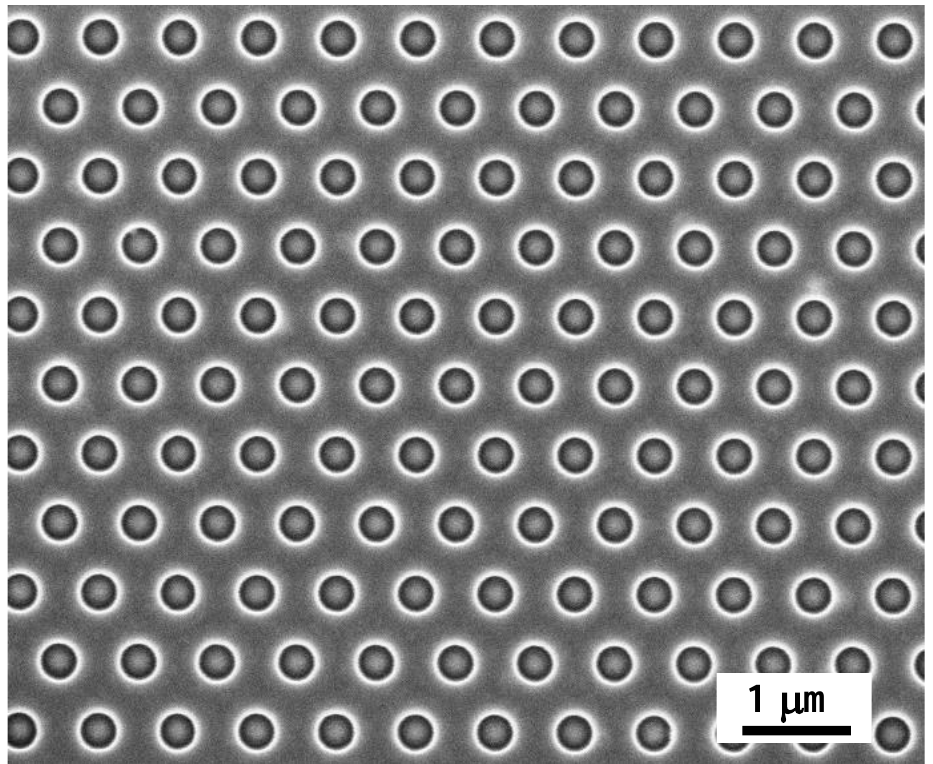
Figure 1. The SEM image of a part of the PCS with a = 700 nm and r/a = 0.25. Experimental studies of the luminescence properties of the fabricated PCSs were car- ried out using two micro-photoluminescence setups, described in detail in [38] and sche- matically presented on Figure 2. In the first one, which was the standard micro-PL setup, the PL signal was excited and collected using the same objective located normal to the sample surface (Figure 2a). In the micro-PL setup, the spatial resolution and the fixed sig- nal collection angle are determined by the objective. For the used «Mitutoyo» M Plan APONIR 10x objective with numerical aperture NA = 0.26, the size of the region under study was 10 μm, which is smaller than the PCS size, and the PL signal was collected in a solid angle 2Θ ~ 30°.